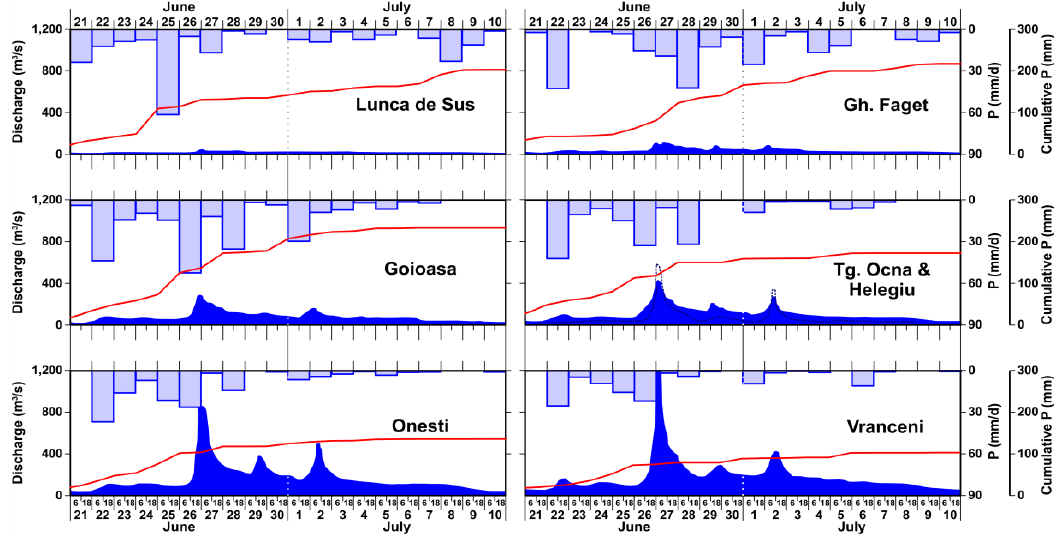
Figure 8. Hydrograph of flood waves and daily intensity of precipitation between 21 June and 10 July 2010, recorded at the hydrometric stations on the Trotus River.